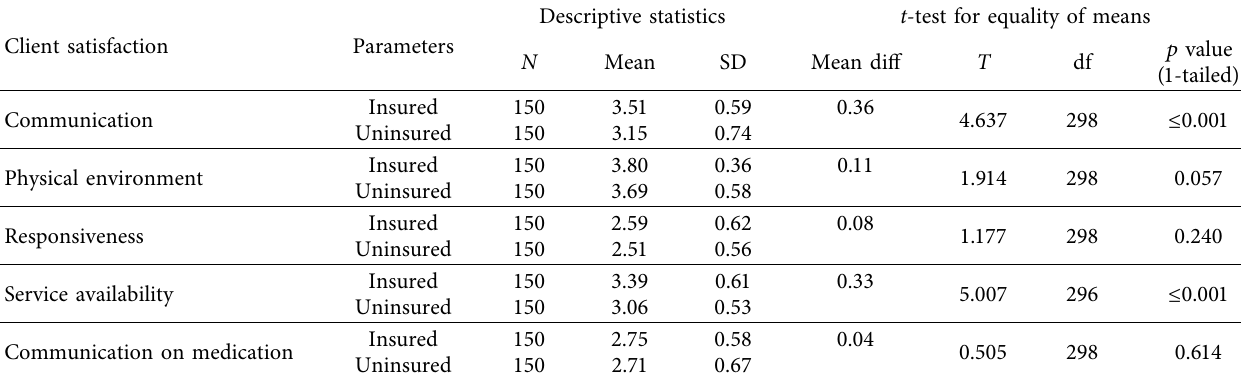
Table 3: Independent sample t -test on insured and